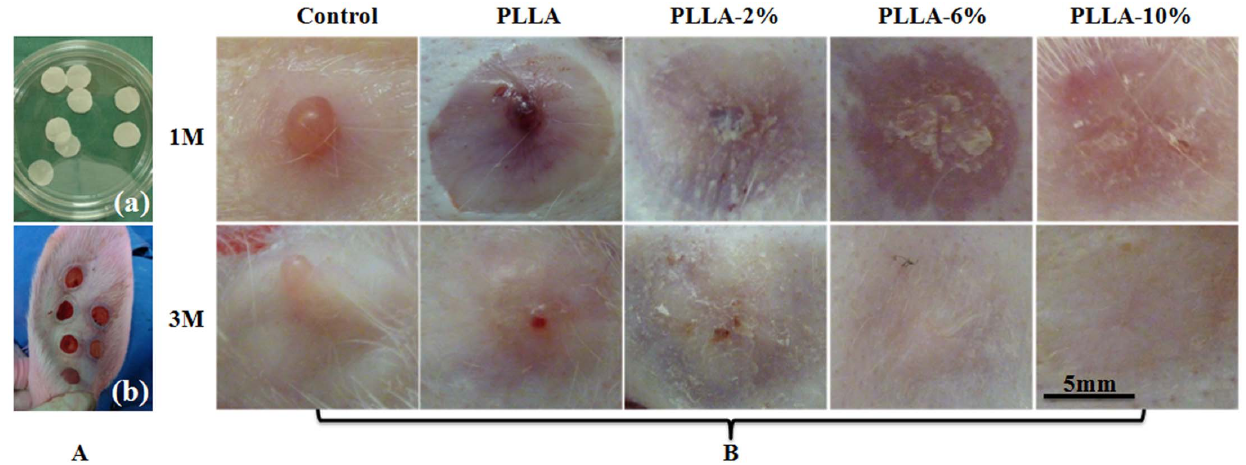
Figure 8. Gross observation of scar hyperplasia harvested on 1 and 3 months of each group. (A) Implanted fibrous scaffolds (a) and rabbits hypertrophic scars model (b); (B) Gross observation of scar hyperplasia treated with blank, PLLA fibers, PLLA-2%, PLLA-6% and PLLA-10% for 1 and 3 months after operation.